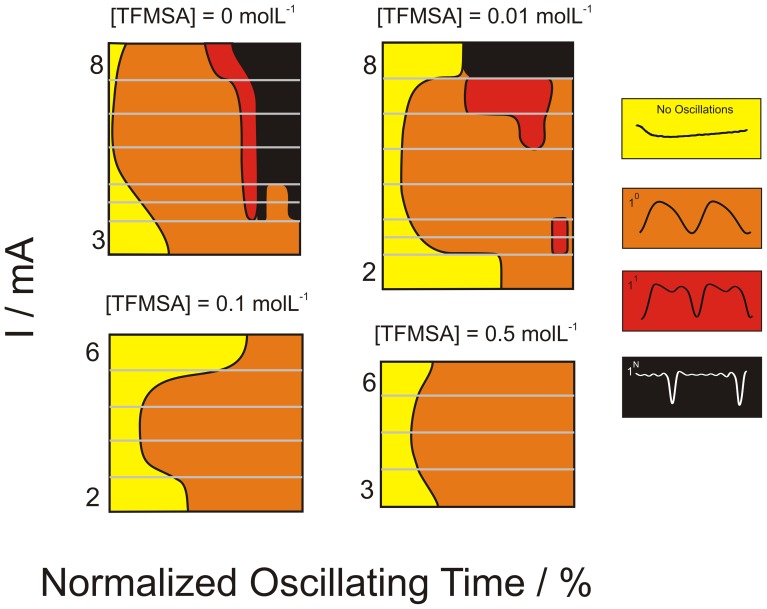
Morphology of oscillations with applied current and amount of anion.Maps presenting the evolution of the morphology of oscillations during the galvanostatic experiments. Each horizontal stripe represents an actual applied current and the gray lines divide different values of current.